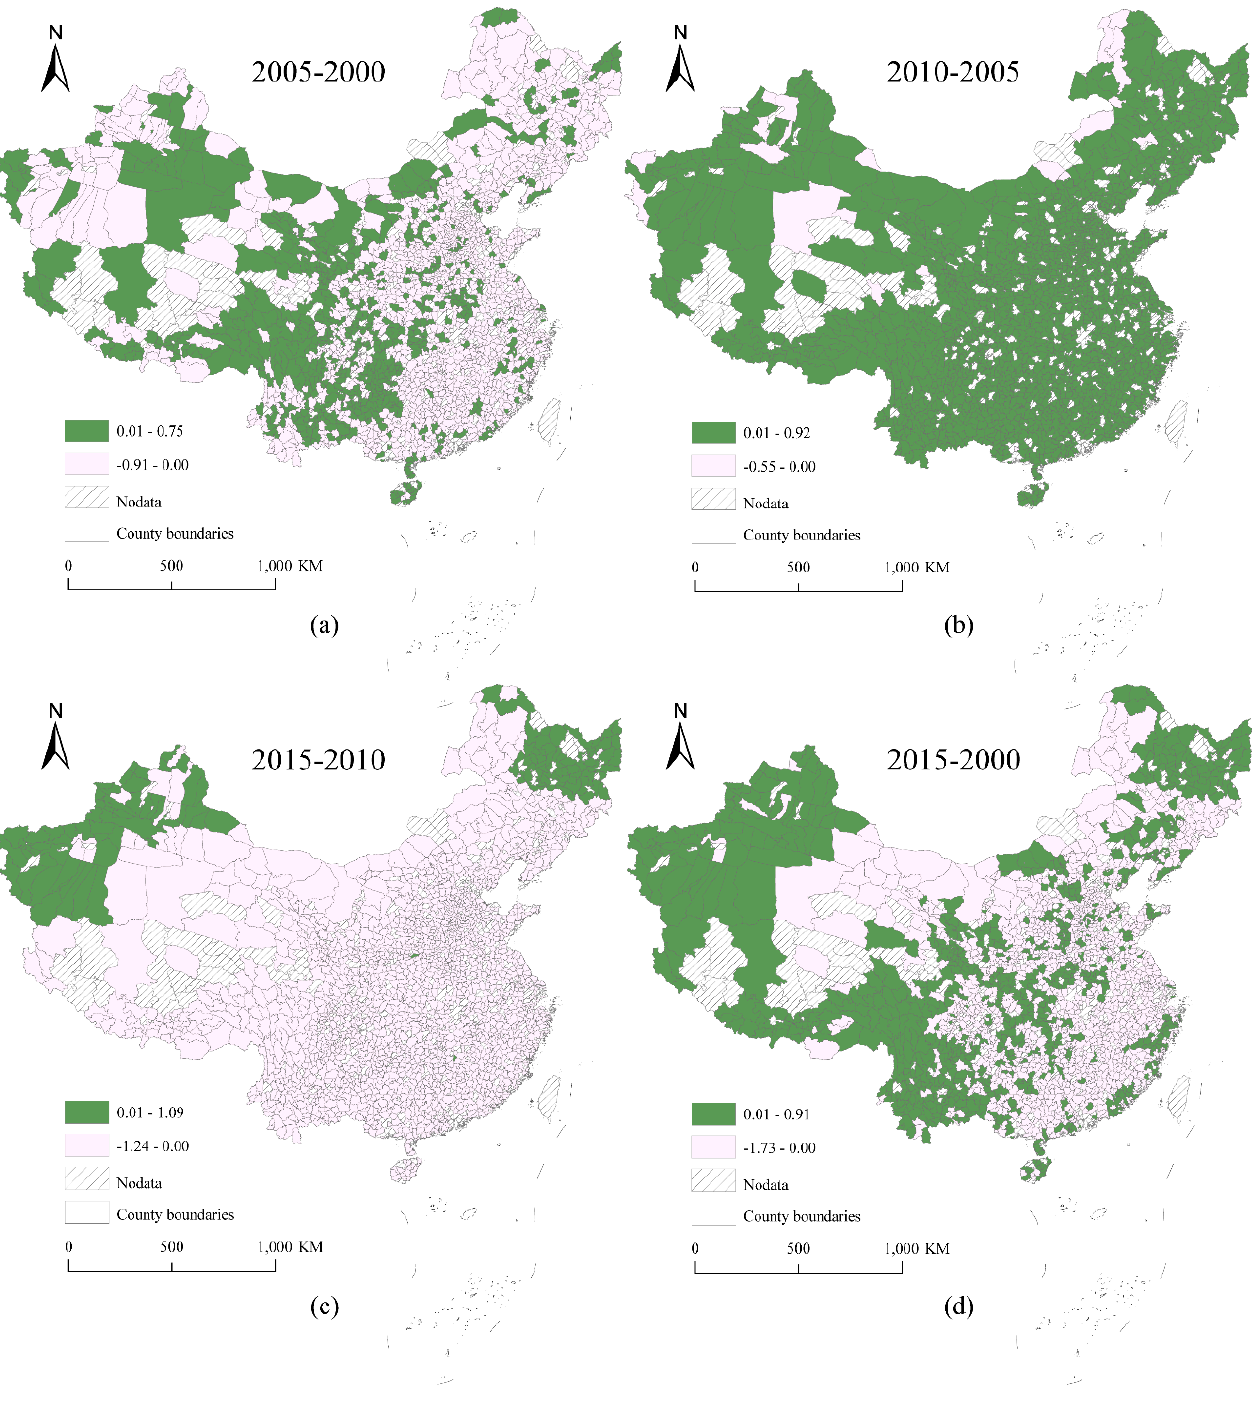
Figure 5. The spatiotemporal dynamics of the CMPI from 2000 to 2015 (Fig.5 (a) to Fig.5 (c) show the changes of CMPI every five years from 2000 to 2015 respectively, and Fig.5 (d) shows the changes of CMPI from 2000 to 2015). A positive value (green block) indicates that the impact of the CMPI has increased compared to the previous